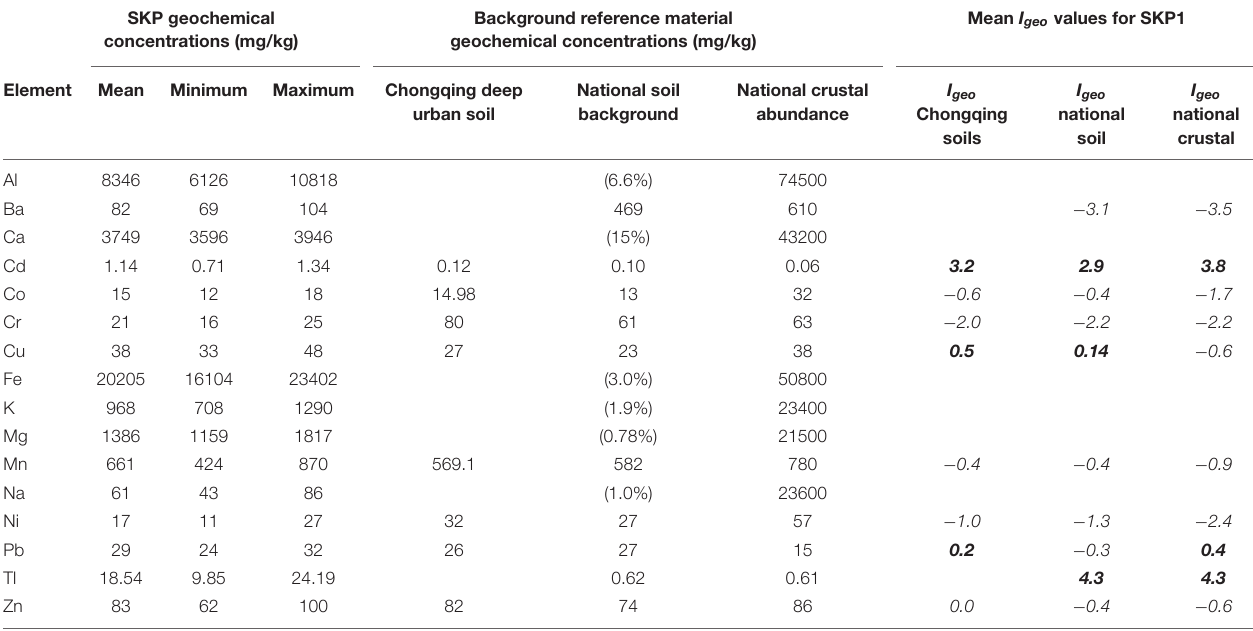
TABLE 3 | Mean, maximum and minimum geochemical concentrations (mg/kg) measured in SKP1 with corresponding background mean concentrations (mg/kg), where available, for urban soils in Chongqing (Cheng et al., 2014; Jia et al., 2018), Chinese soil background (Teng et al., 2014) and Chinese continental crustal abundance (Tong, 1995; Min et al.,